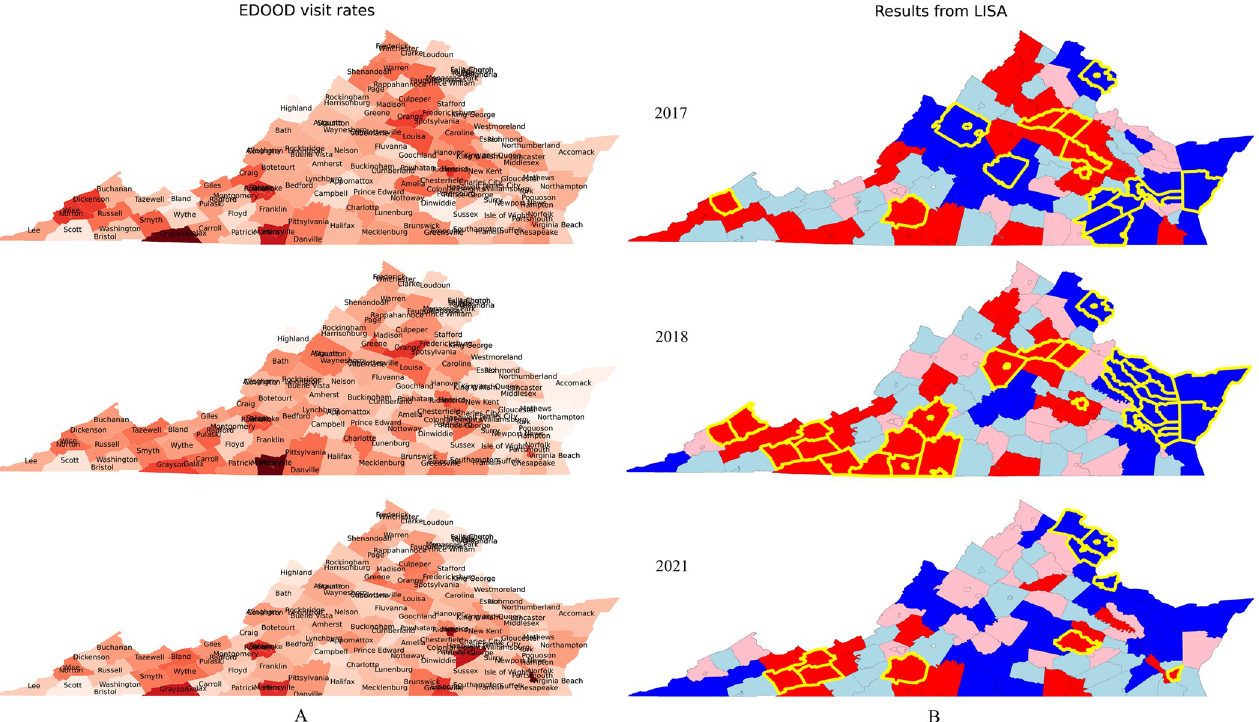
Fig 2. Choropleth plots of (A) EDOOD visit rates (darker color signifies higher rates), and (B) results from LISA analysis returned for the years 2017, 2018, and 2021 highlighted by different colors (red: high-high–hot spots, blue: low-low–cold spots, pink: high-low, light blue: low-high). The yellow border marks the significant